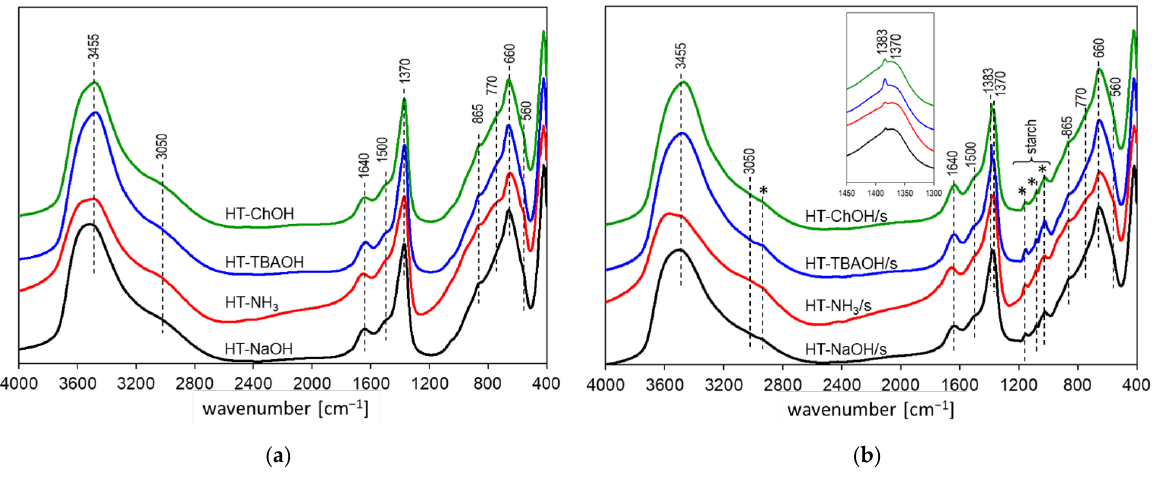
Figure 4. FTIR spectra of HT materials obtained with the use of different precipitating bases: ( a ) synthesis in water ( b ) synthesis in aqueous starch solution (starch bands marked with asterisks).